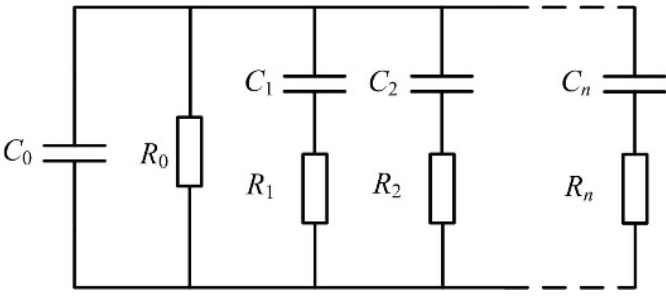
Figure 1. The structure of the extended Debye model.